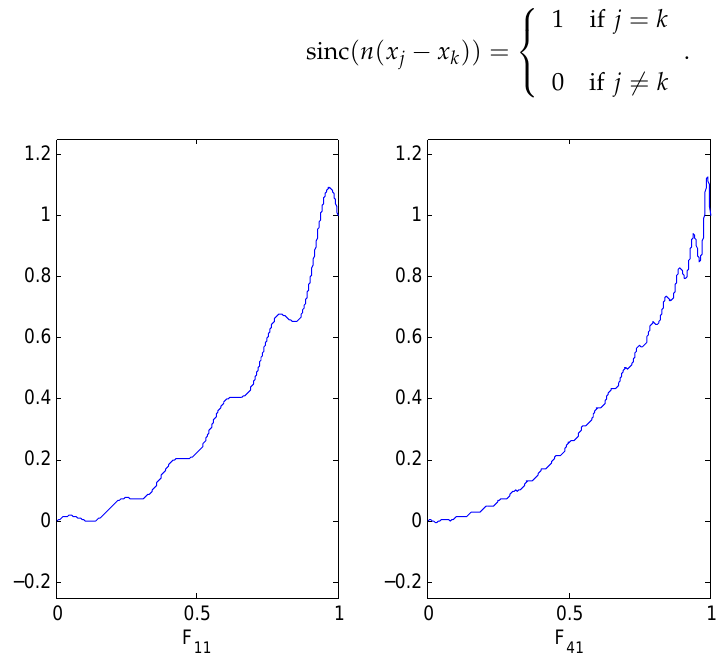
Figure 1. F n ( x ) for f ( x ) = x 2 and n = 11 and n =